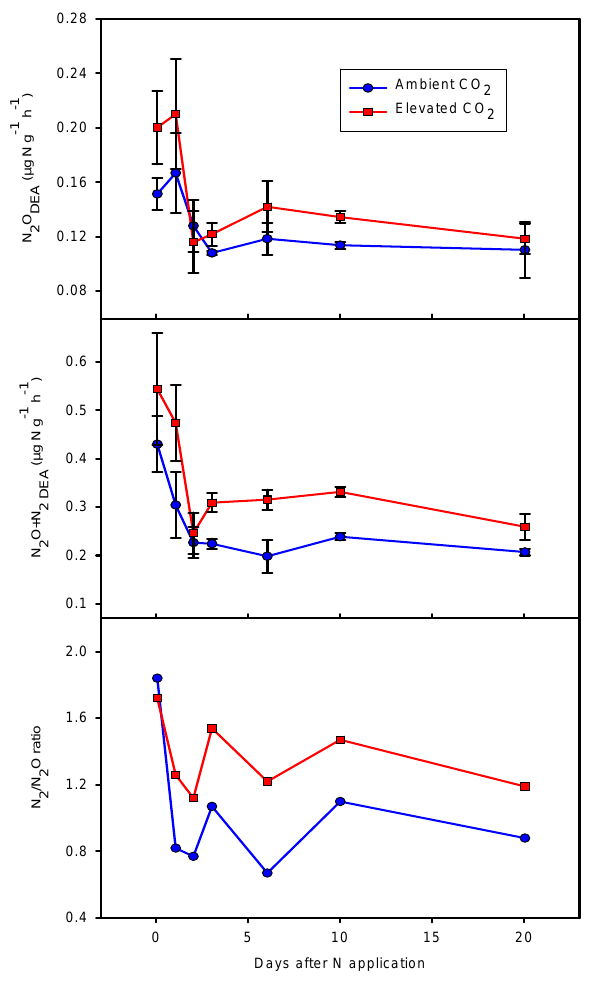
Fig. 4. Emission of N 2 O, total denitrification (N 2 O+N 2 ) (µg N g ‐ 1 h ‐ 1 ) and N 2 /N 2 O ratio (AVG ±SD) from temperate grassland soil exposed to elevated CO 2 and soil without elevated CO 2 treatment i.e. ambient incubated under controlled laboratory conditions following the application of NH 415 NO 3 and 15 NH 4 NO 3 .